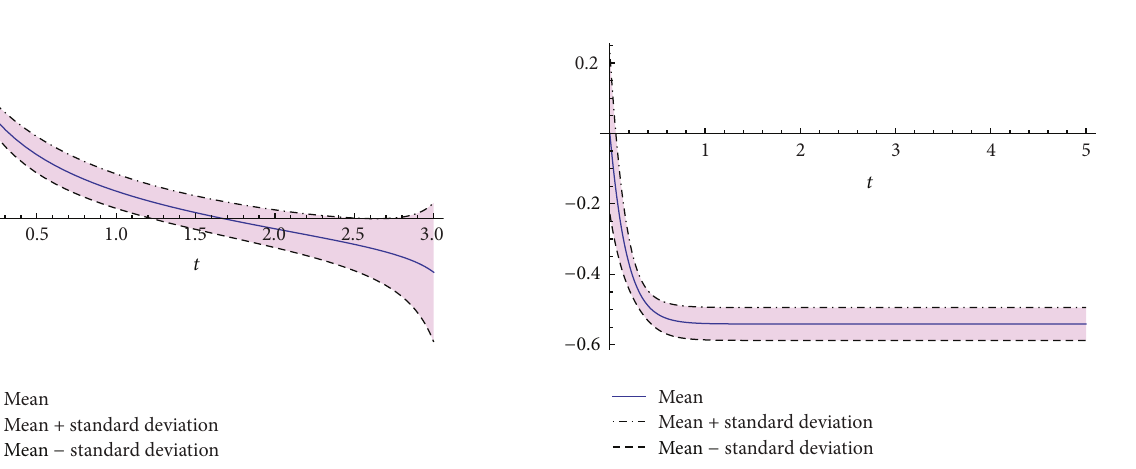
Figure 6: Approximations of the expectation (solid line) and plus/minusstandarddeviation(dashedlines)tothesolutions.p. 𝑦(𝑡) on the interval [0, 3] in Example 4.